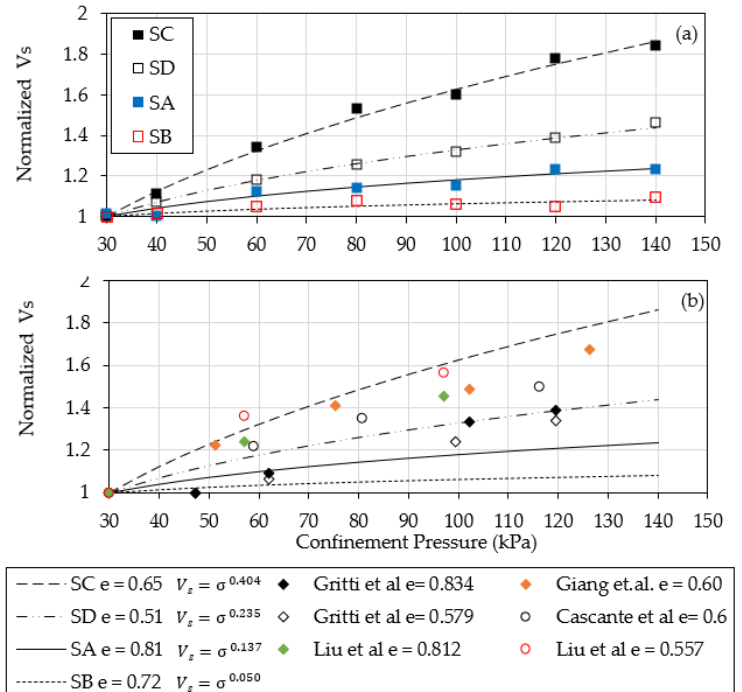
Figure 5. ( a ) Variation of normalized power models of shear wave velocity (Vs) with confinement ( σ ) for samples SA, SB, SC, and SD (data also shown). ( b ) Comparison of models with selected past studies on calcareous and silica sand (circular markers).